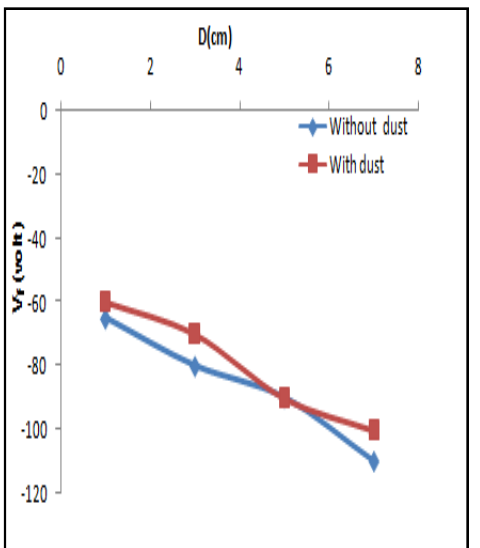
Fig.9: The floating potential with Diameter at different distances of the